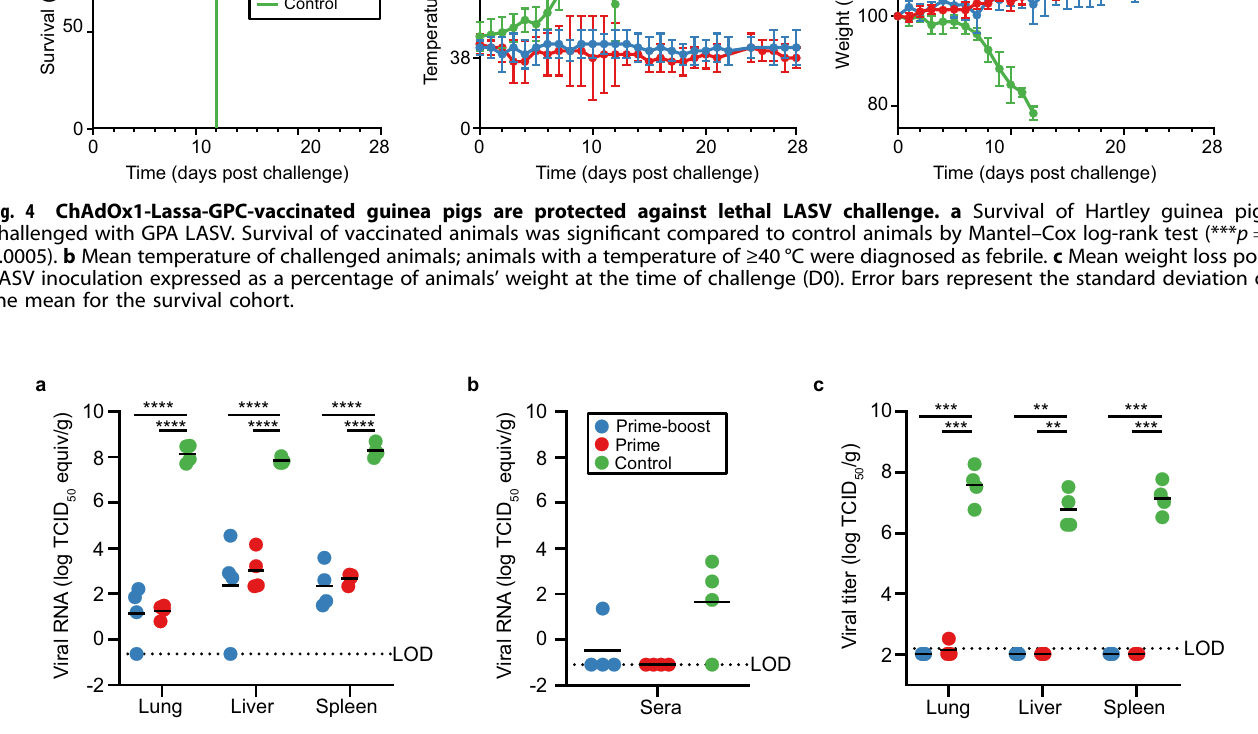
Fig. 5 Viral load is signi fi cantly lower in the tissues and sera of ChAdOx1-Lassa-GPC vaccinates compared to controls. Lung, liver, spleen, and sera samples were collected from animals ( n = 4/group) during post-challenge necropsy (D12). Detection of LASV RNA in the tissues ( a ) and sera ( b ) of vaccinated and control animals by qRT-PCR. The dotted lines represent the limits of detection (LOD) for analysis of tissue ( − 0.64 log TCID 50 /g equivalents) and sera ( − 1.10 log TCID 50 /mL equivalents) due to distinct inactivation methods used to remove these samples from BSL4 containment. Differences in viral load in the lung, liver, and spleen of vaccinated animals versus controls were statistically signi fi cant by two-way ANOVA with Tukey ’ s multiple comparisons test (**** p < 0.0001). Levels of LASV RNA detected in sera did not differ signi fi cantly between groups by Kruskal – Wallis nonparametric test with Dunn ’ s multiple comparisons. c Infectious virus titers in tissues positive for LASV RNA (lung, liver, and spleen) were determined via endpoint titration on Vero E6 cells. The dotted line represents the LOD (2.20 log TCID 50 /g). Differences in virus titers between vaccinated and control animals were statistically signi fi cant in all tissues by two-way ANOVA with Tukey ’ s multiple comparisons test (** p = 0.0012, *** p = 0.0008, 0.0006,